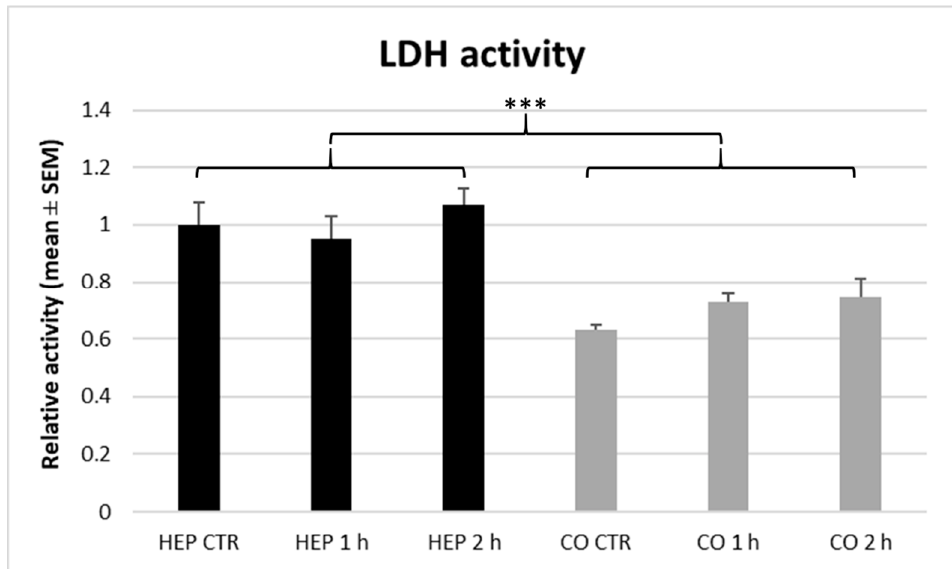
Figure 6. The lactate dehydrogenase (LDH) activity of hepatocyte mono-cultures (“HEP”) and hepatocyte—nonparenchymal cell co-cultures (“CO”) as indicated by specific photometric assay. The “CTR” refers to control cells with no heat exposure, while “1 h” and “2 h” indicate incubation of cell cultures at 43 °C for 1 h or 2 h, respectively. Relative activities were calculated by considering the mean value of control hepatocyte mono-cultures as 1. Results are expressed as mean ± standard error of the mean (SEM), n = 3/group. Asterisks over bars of “1 h” and “2 h” refer to significant differences compared to “CTR” cells within the same cell culture model. Significant differences between cell culture models are indicated with asterisks on the clamps. *** p < 0.001.